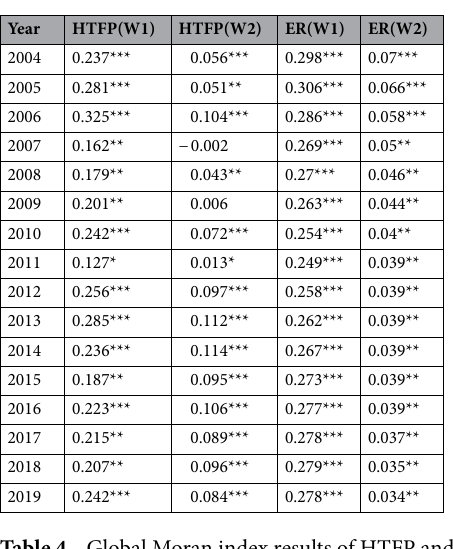
Table 4. Global Moran index results of HTFP and ER. *, **, ***indicate significance at the 10%, 5% and 1% level, and the standard errors are in parentheses.